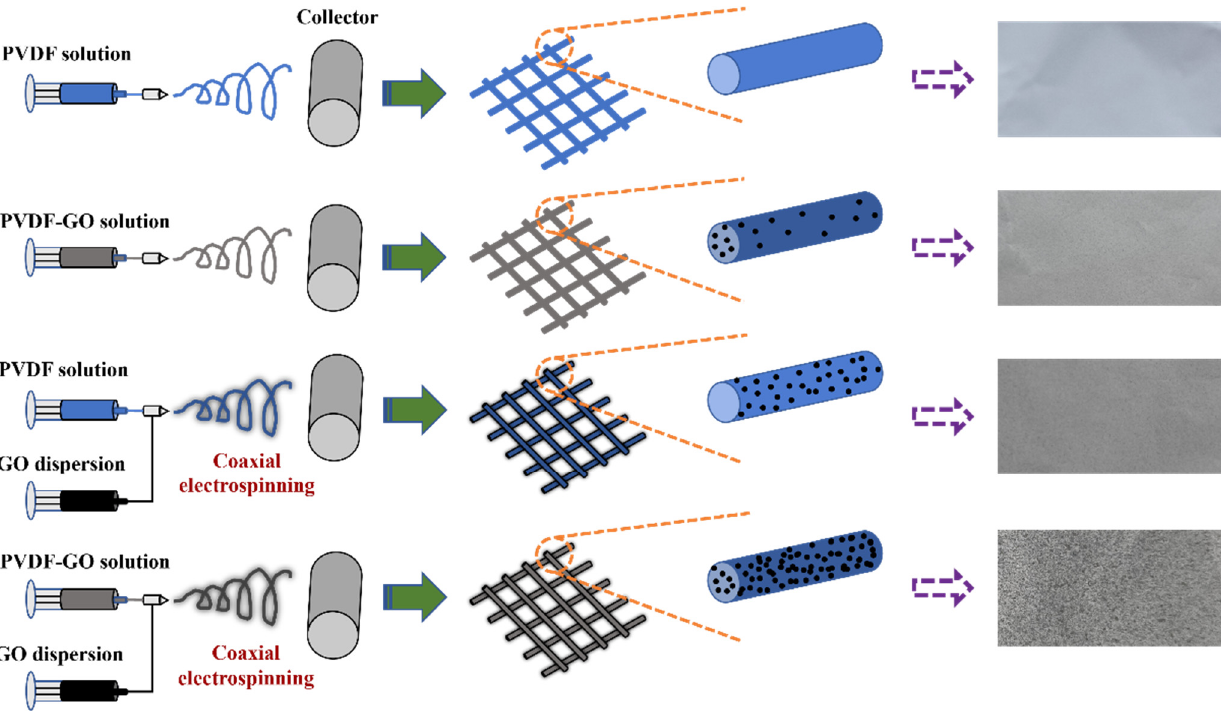
Figure 1. Schematic diagram of preparation by different electrospinning strategy: ( a ) preparation of original PVDF ENFM, ( b ) blended electrospinning, ( c ) coaxial electrospinning, and ( d ) coaxial electrospinning combined with blended electrospinning .